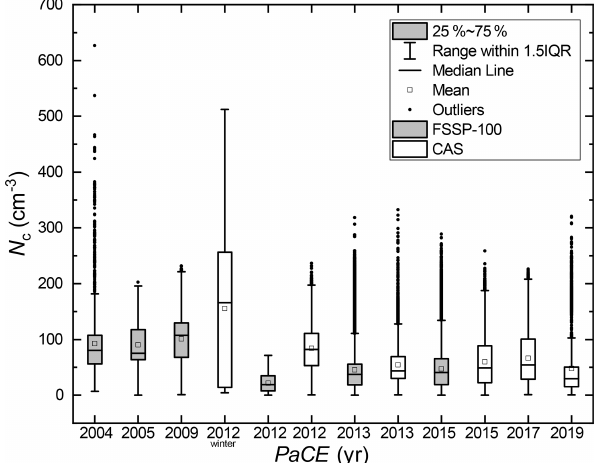
Figure 7. Statistical description of N c for each PACE campaign during which the FSSP-100 and CAS ground setups were opera- tional.